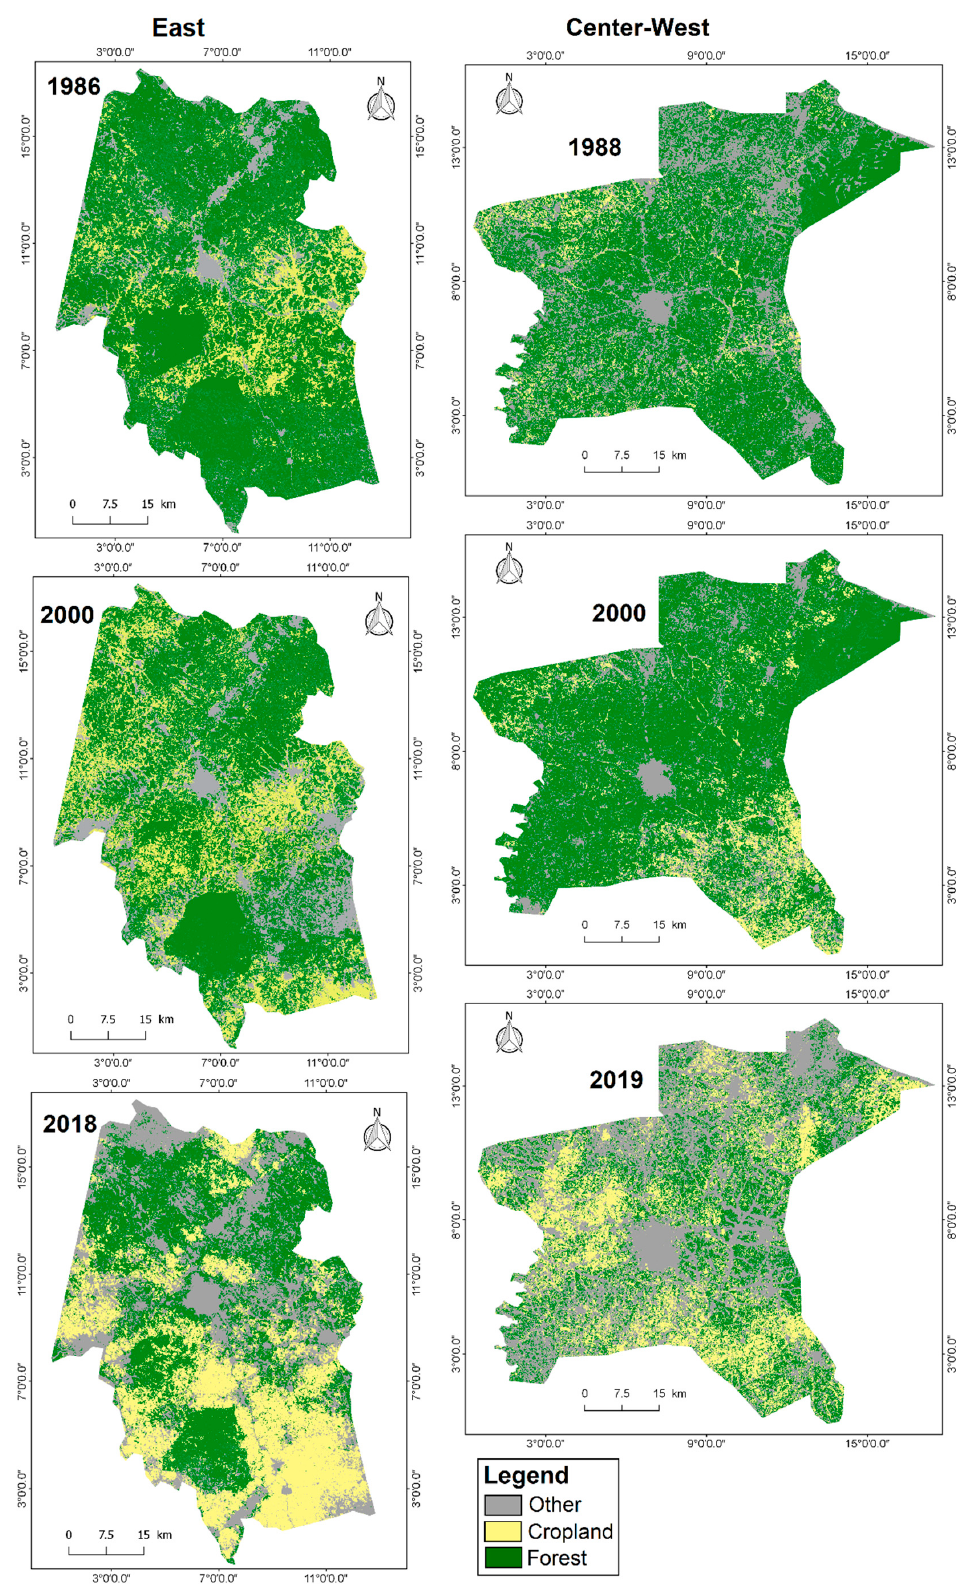
Figure 3. Land-cover maps of the Abengourou ( left ) and Daloa ( right ) region.